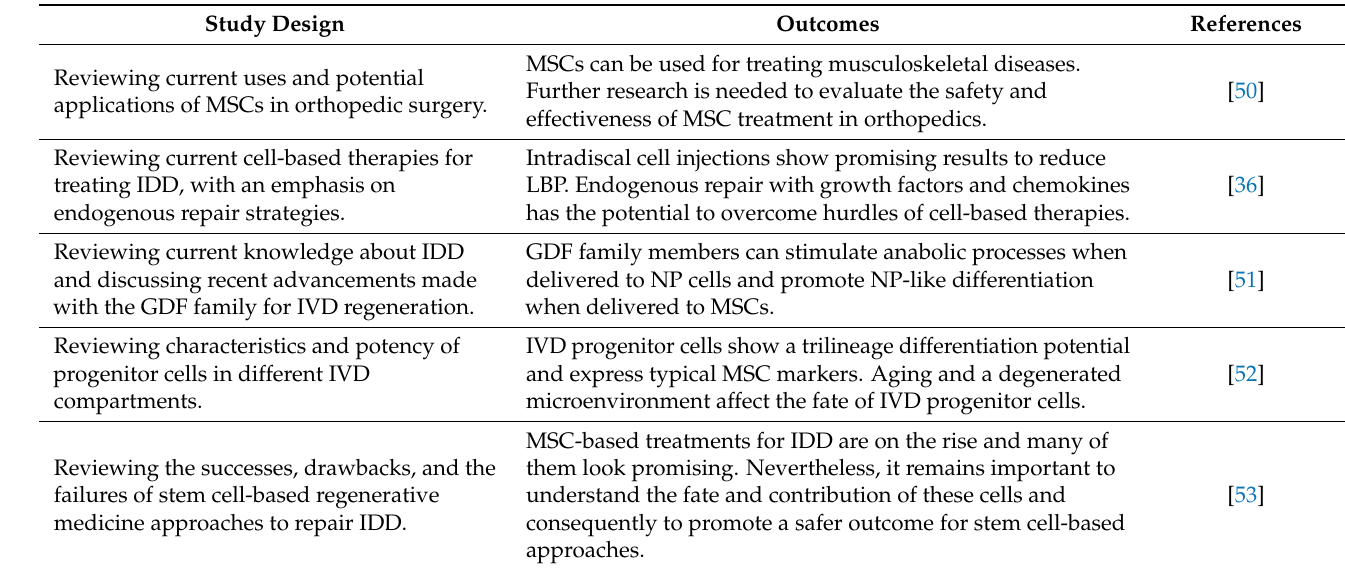
Table 1. Overview of reviews on preclinical studies about the application of MSCs for IVD regeneration published in the past five years. PubMed search with following query box: (((MSC) OR (mesenchymal stem cell)) OR (mesenchymal stromal cell)) AND ((intervertebral disc repair) OR (intervertebral disc regeneration)) Filters: Review, Systematic Review, in the last 5 years. Reviews with a focus on clinical trials were excluded. The search on PubMed was conducted on January 14,